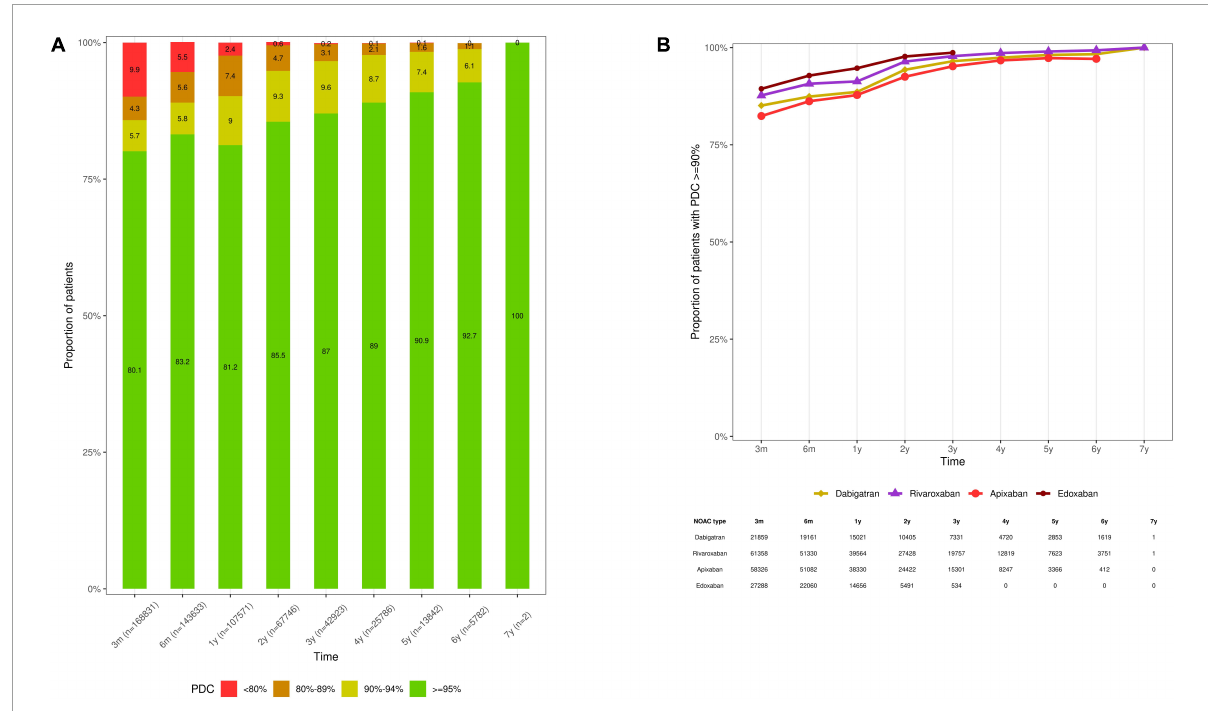
FIGURE5 Therapy adherence of (A) persistent NOAC users, categorized according to a PDC of < 80%, 80- < 90%, 90- < 94%, and ≥ 95%, and (B) the proportion of persistent dabigatran, rivaroxaban, apixaban and edoxaban users with a PDC of ≥ 90% at specific time intervals. Subjects were censored in case of NOAC discontinuation, switching to any other OAC type, death, emigration, or end of the study period. Due to their respective approval in September 2013 and October 2016, and the study period ending on December 31st, 2019, the maximum follow-up duration of apixaban and edoxaban users was limited to 6.3 and 3.25 years, respectively. Only persistent NOAC users with a follow-up at least corresponding with the examined time interval were investigated (e.g., PDC after 1 year in the subgroup of subjects with ≥ 1 year of follow-up), as illustrated by the number of investigated subjects (n) per time point. M, months; NOAC, non-vitamin K antagonist oral anticoagulant; OAC, oral anticoagulant; PDC, proportion of days covered; VKA, vitamin K antagonist; y,